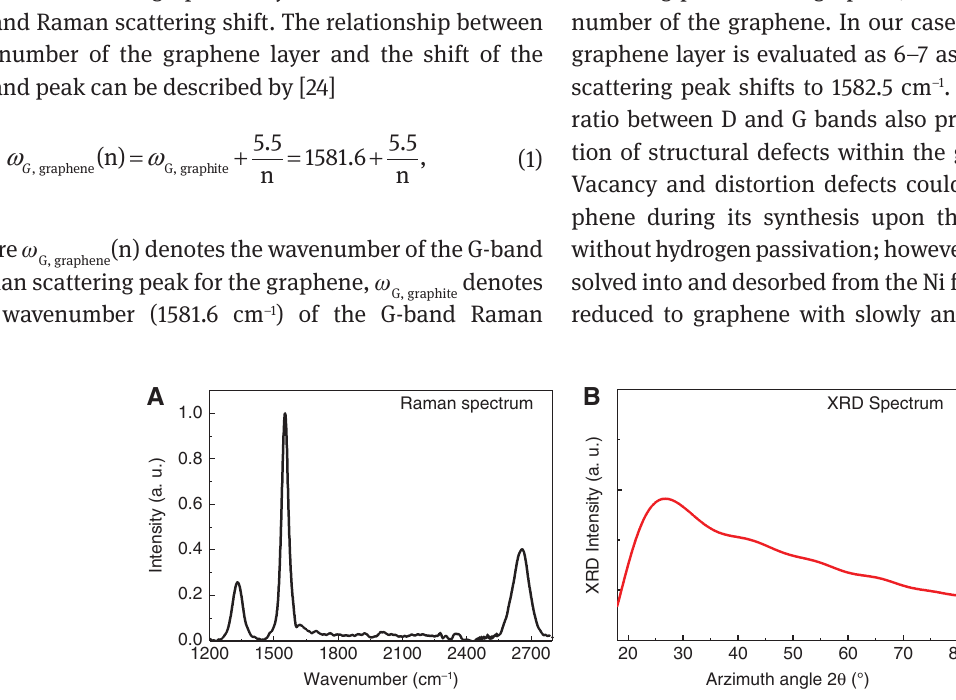
Figure 3: (A) Raman scattering spectrum and (B) XRD spectrum of few-layer graphene synthesized by hydrogen-free PECVD to observe the layer number and crystallinity of the few-layer graphene.